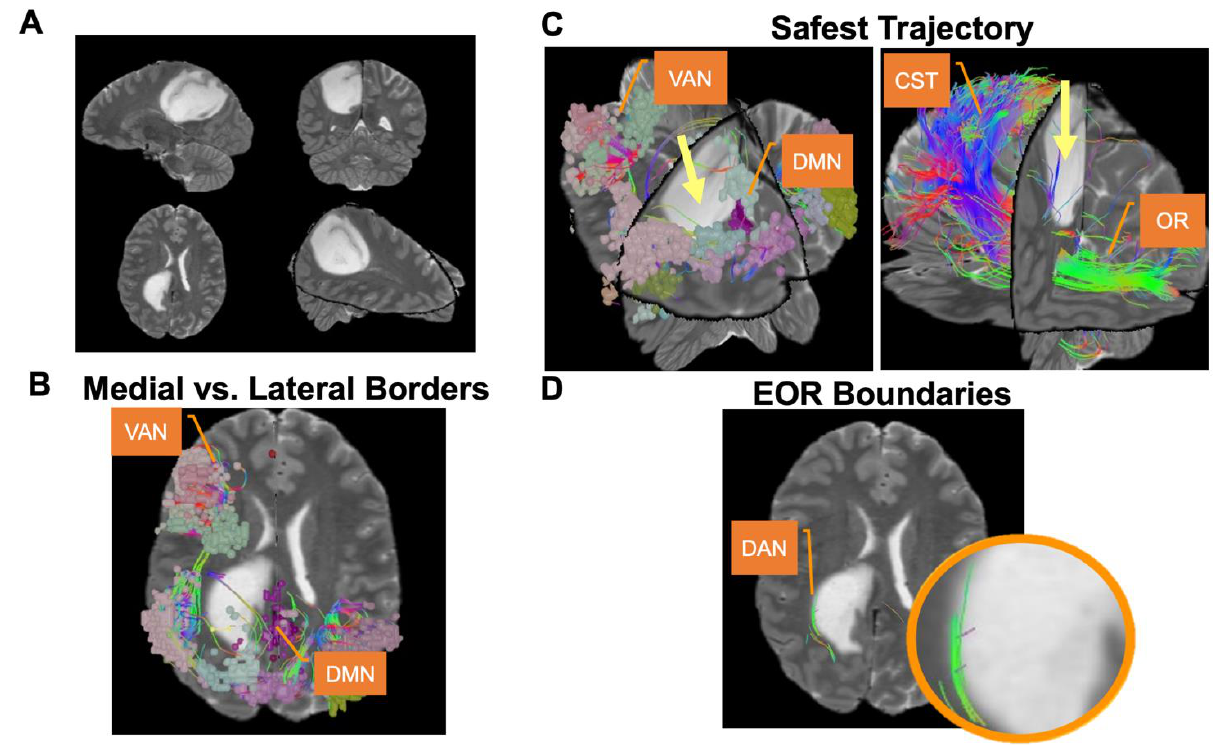
Figure 6. Use of Brain Network Maps for Glioma Surgery. Consideration of the non-traditional, large-scale brain networks is utilized in a case example of a patient with a right parietal anaplastic oligodendroglioma. ( A ) T2-weighted magnetic resonance imaging is shown in sagittal (top left), coronal (top right), axial (bottom left), and three-dimensional (bottom right) views. ( B ) The tumor is preoperatively defined against the ventral attention network (VAN) as the lateral boundary and the default mode network (DMN) as the medial boundary. ( C ) A trajectory is chosen against brain networks so as to minimize unnecessary network disturbances on the entry to the tumor. ( D ) A zoomed-in view demonstrates the tumor margin pressed against the superior longitudinal fascicu- lus (SLF) of the dorsal attention network (DAN).